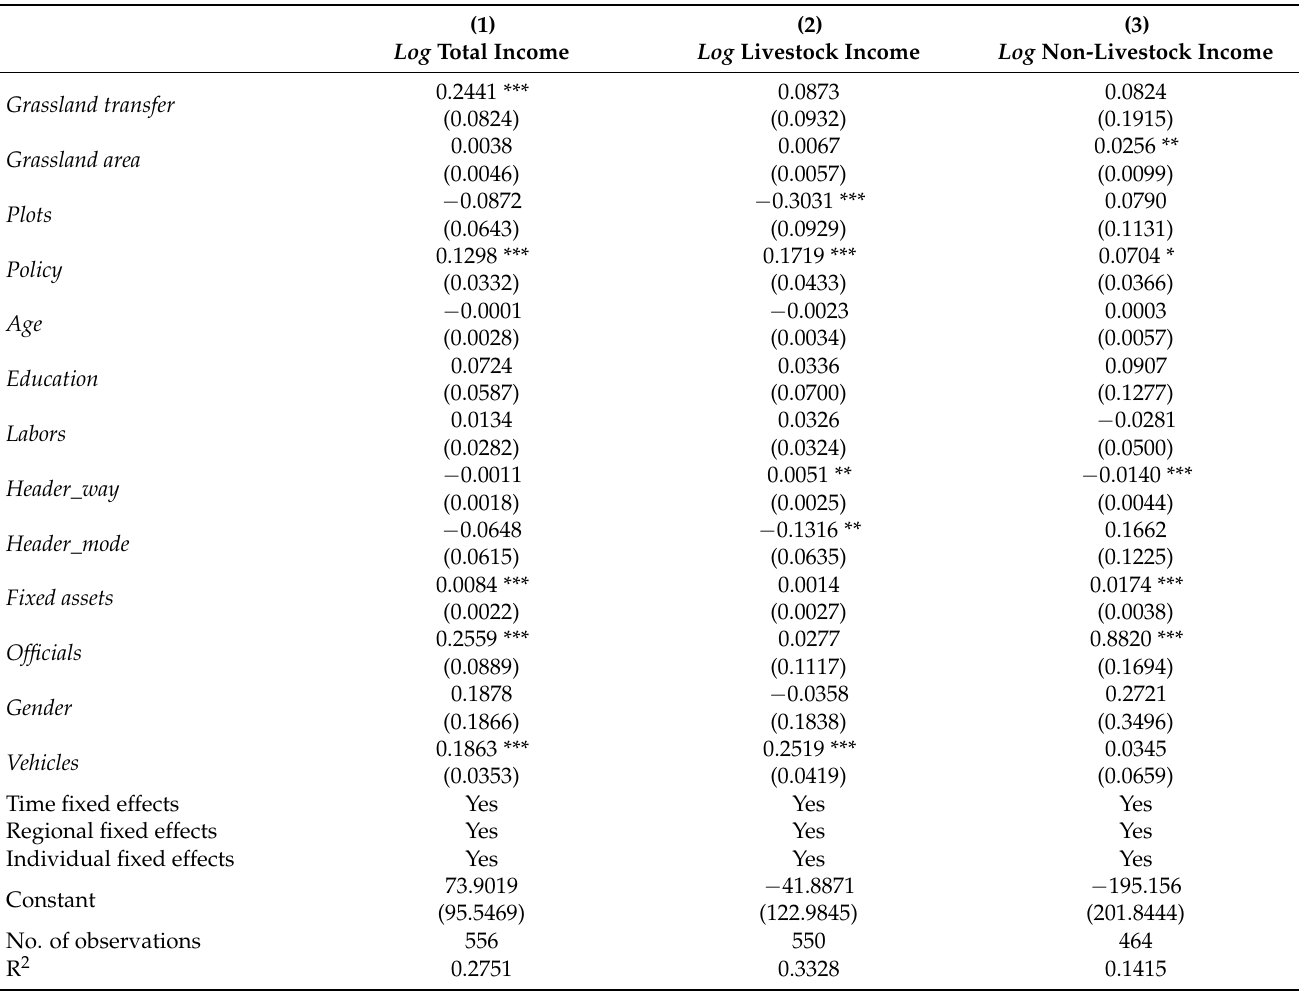
Table 2. The impact of grassland transfer on household